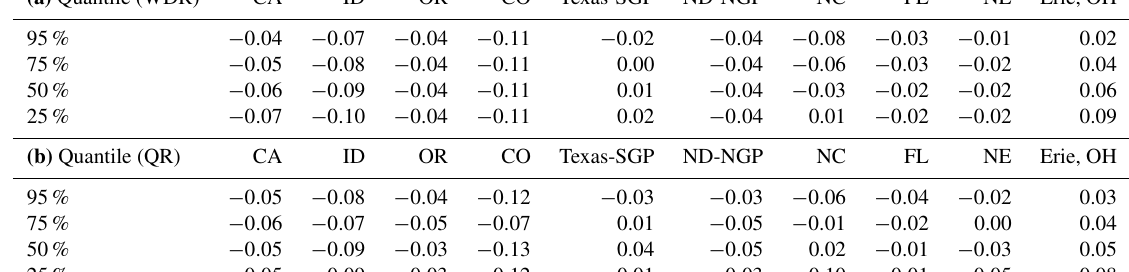
Table 2. Relative changes in different quantiles for CCSM-4 data in winter between projected period (2085–2094) and historical period (1995–2004). Quantiles are estimated with a Weibull distributional regression, WDR (a) , and quantile regression, QR (b) .